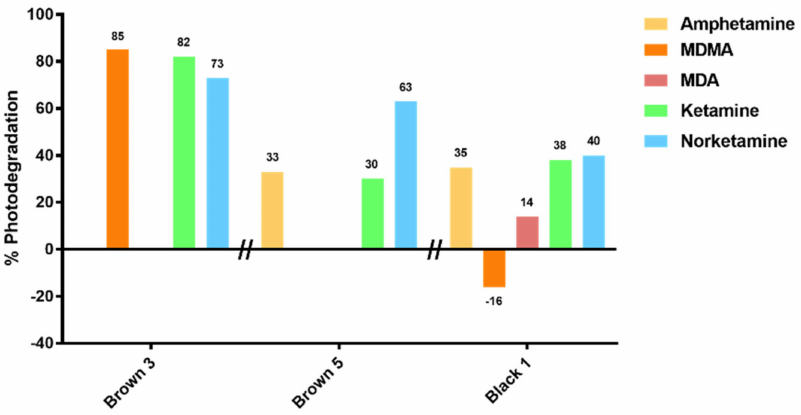
Figure 7. Percentage of photodegradation of amphetamine (AMF), KET, and NKET in three different hair samples. In these three samples, photodegradation seems to depend on the hair